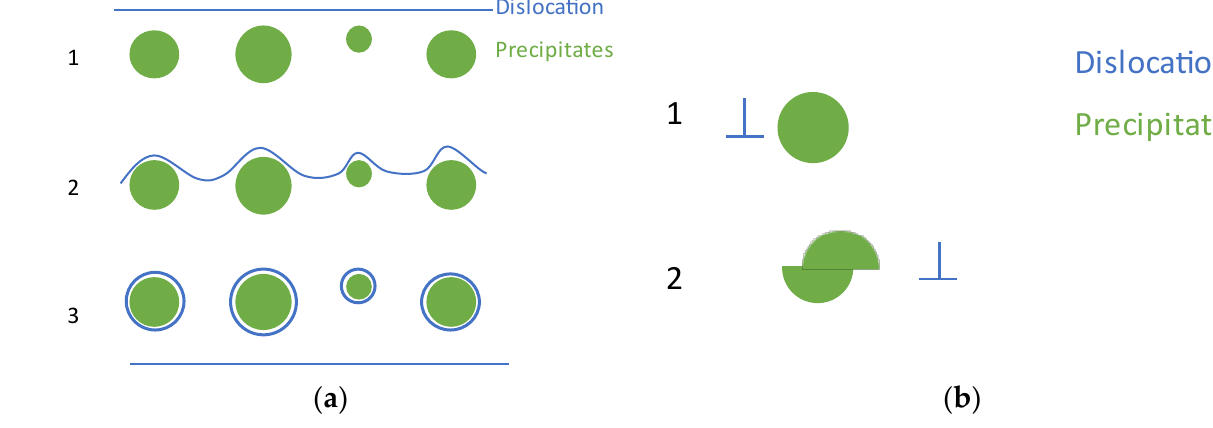
Figure 10. Precipitation hardening mechanisms: ( a ) dislocations surround precipitates; ( b ) dislocations cut precipitates (if below critical precipitation size).